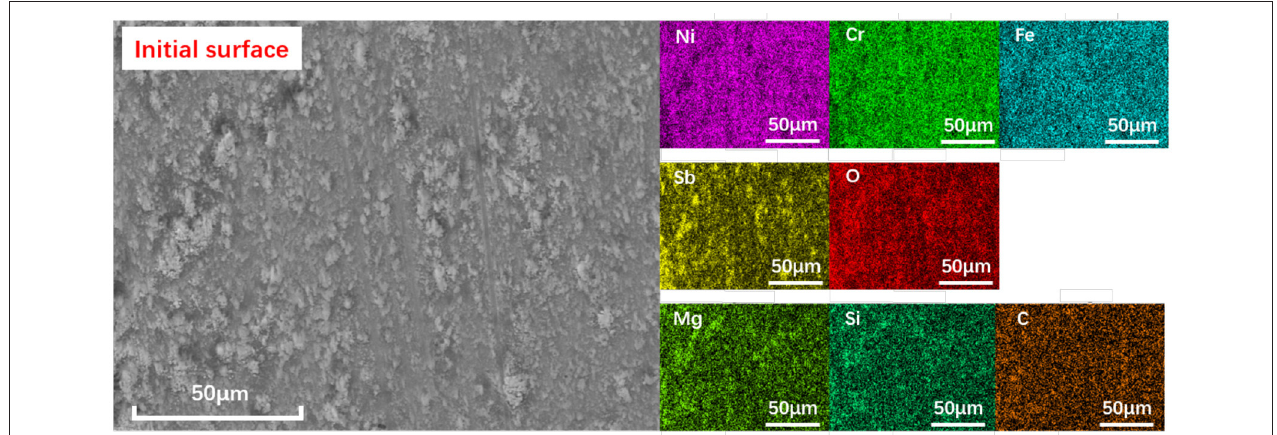
FIGURE 3 | The SEM and the elemental mapping images of as-prepared Sb 2 O 3 -MSH/C surface. High uniformity of the particle distribution on the surface is observed.